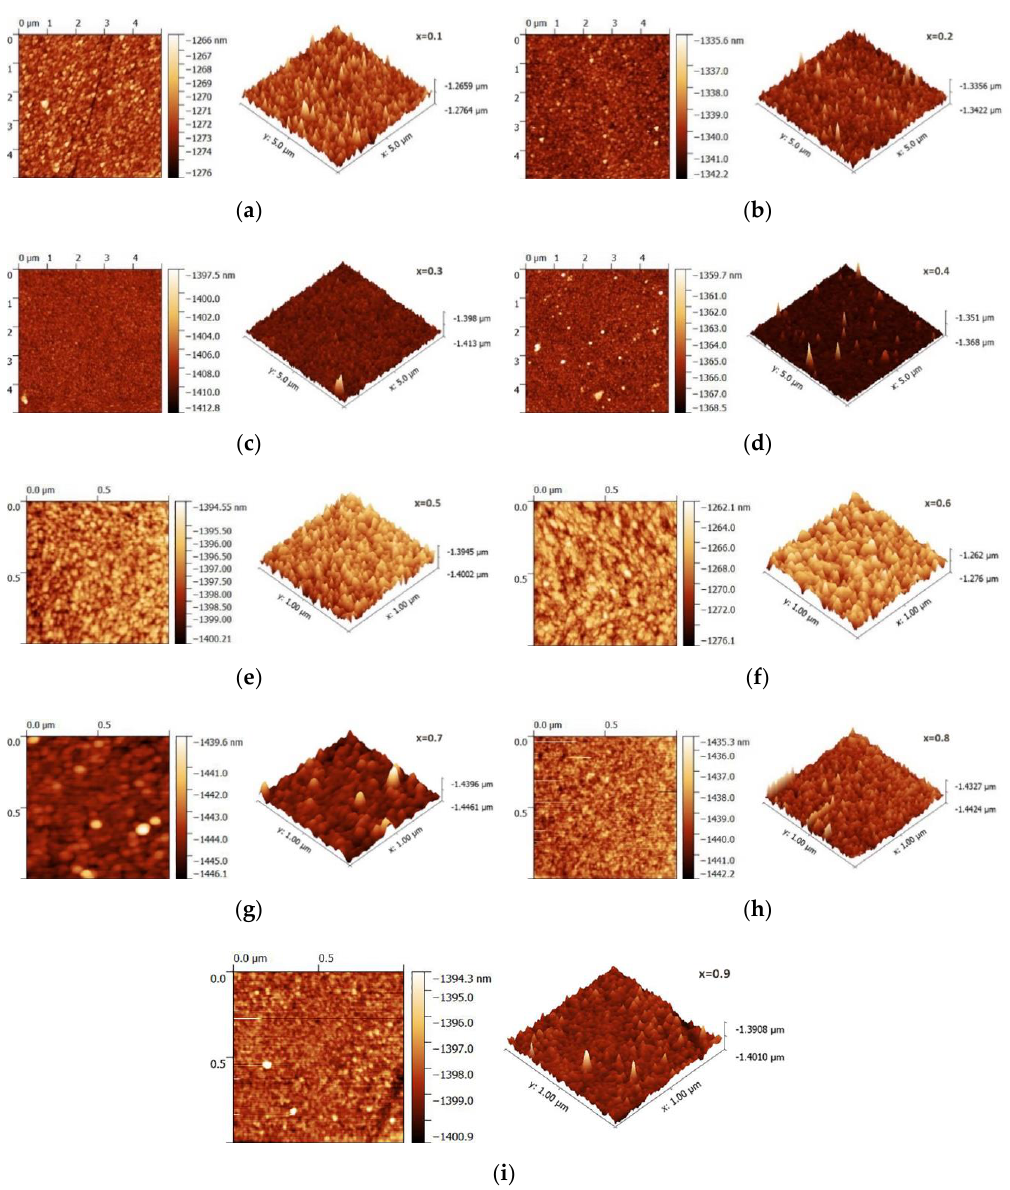
Figure 5. AFM of Zn 1-x Mg x S thin films (0.1 ≤ x ≤ 0.9): ( a ) x = 0.1; ( b ) x = 0.2; ( c ) x = 0.3; ( d ) x = 0.4; ( e ) x = 0.5; ( f ) x = 0.6; ( g ) x = 0.7; ( h ) x = 0.8; ( i ) x = 0.9.